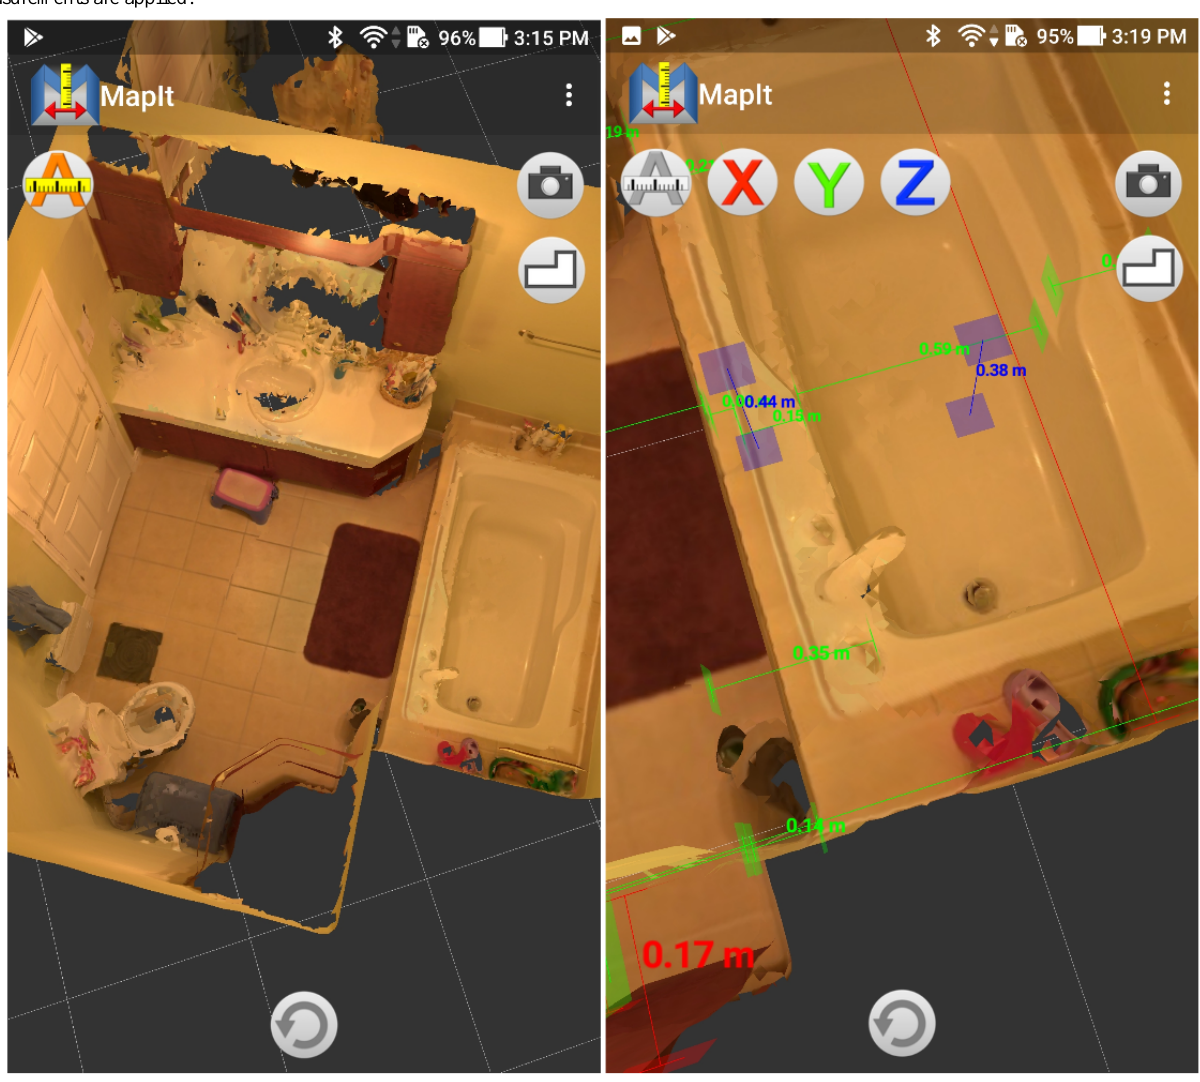
Figure 4. Phone app interface (V 0.4.1) when visualizing a scan. On the left, no automatic measurements were applied while on the right, automatic measurements are